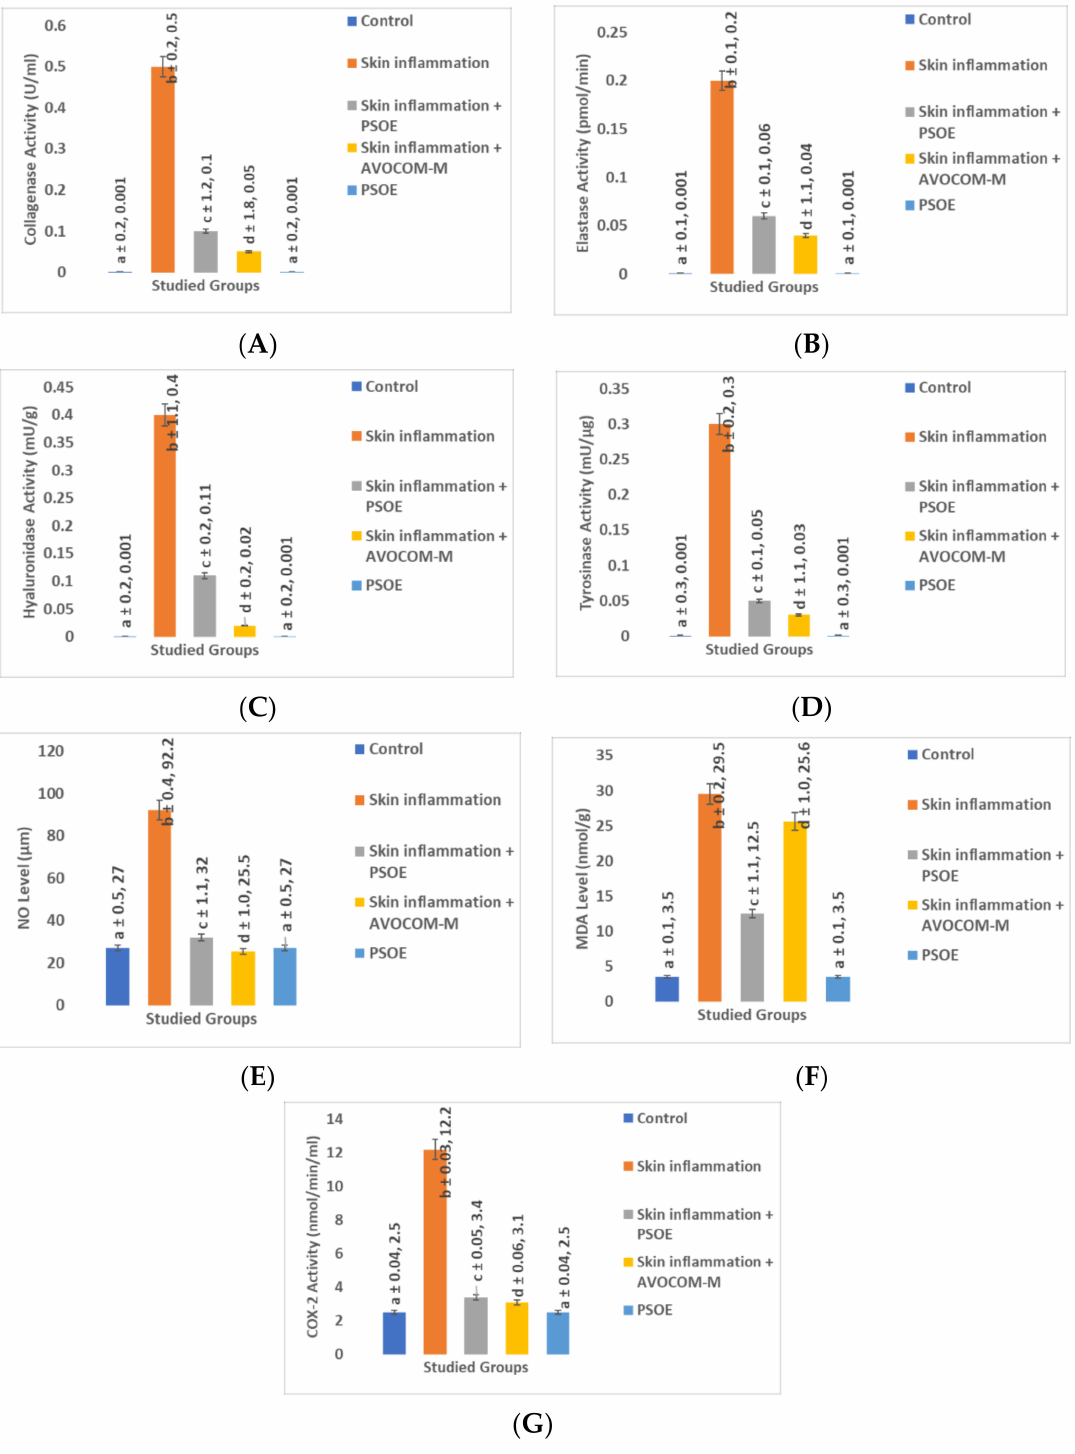
Figure 2. Biochemical comparison of different groups in rat skin investigation. ( A ) Collagenase; ( B ) elastase; ( C ) hyaluronidase; ( D ) tyrosinase; ( E ) nitric oxide (NO); ( F ) malondialdehyde (MDA); and ( G ) cyclooxygenase2 (COX-2) levels in five rat groups. Rats in the control group ( C ) were